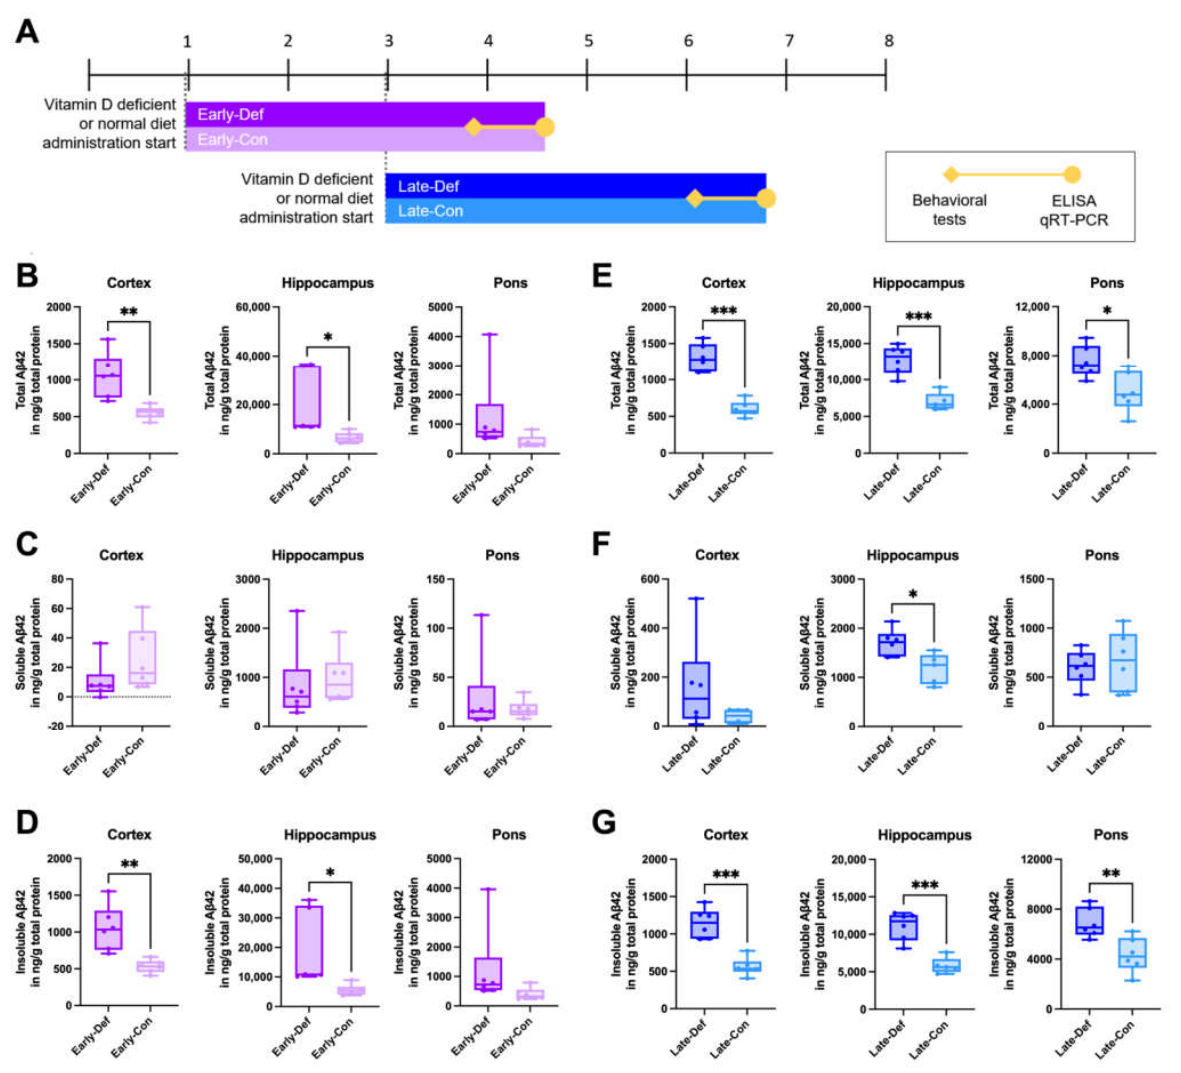
Figure 1. Vitamin D deficiency increased the A β load in both the early and late stages of AD model mice. ( A ) Experimental scheme of a vitamin D-deficient state in 5xFAD mice induced by the administration of a vitamin D-depleted (0 IU) diet. One-month-old mice in the Early-Def ( n = 6) and Early-Con ( n = 6) groups were given vitamin D-depleted and normal diets, respectively. Late-Def ( n = 6) and Late-Con ( n = 6) group mice were given a vitamin D-depleted diet and normal diet, respectively, starting from 3 months old. ( B ) The total A β 42 levels in the cortex, hippocampus, and pons of the 4.5-month-old Early-Def and Early-Con groups were measured using ELISA kits. ( C ) Soluble and ( D ) insoluble A β 42 levels were also represented. ( E ) The total A β 42 levels in the cortex, hippocampus, and pons of the ~7-month-old Late-Def and Late-Con groups are indicated. ( F ) The soluble and ( G ) insoluble A β 42 levels are also depicted. Dots represent the data of individual mice in each group. The data are presented by the mean ± SEM of each group. * p < 0.05, ** p < 0.01, and *** p < 0.001 by the Student’s t